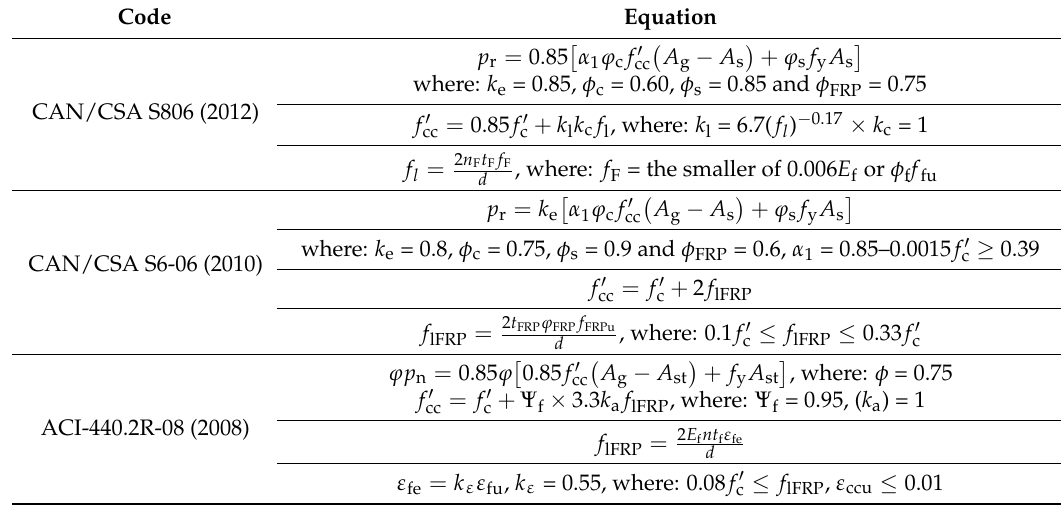
Table 1. Axial load-carrying capacity design equations used for concrete-filled, fiber-reinforced polymer (FRP) tube (CFFT)